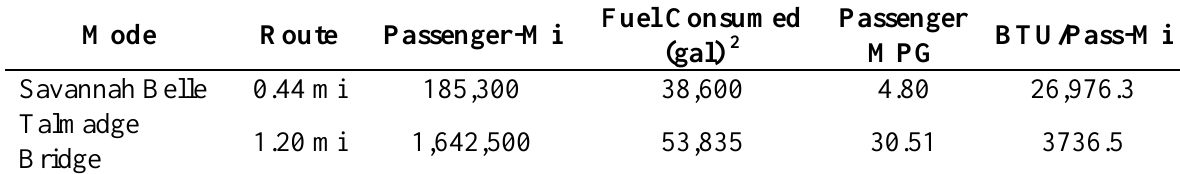
Table 3. Year 2008 Savannah Belle Ferry and Talmadge Bridge Statistics 1